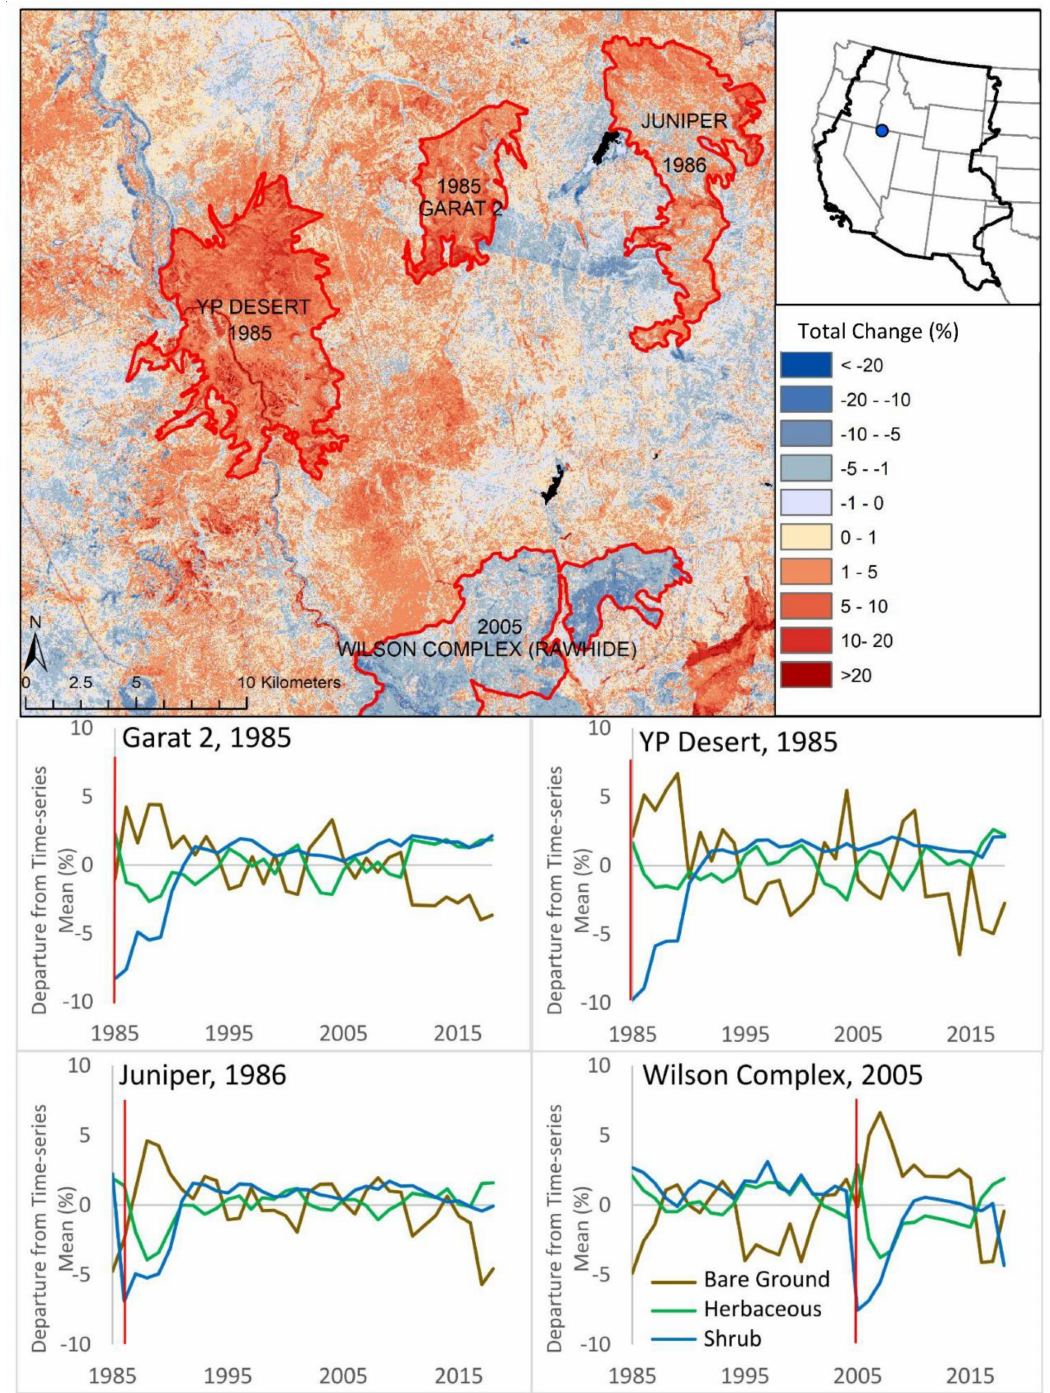
Figure 9. Examples of the impacts of wildfire (timing indicated with vertical red line) on component cover values and the trajectories of recovery following burns in southwest Idaho and north central Nevada (location shown on inset map). The impacts of fire were plotted by calculating the departure from the time-series mean component cover in each burned area separately, where positive values indicate higher component cover than the long term mean in that year. Data reflect the mean condition within each burned